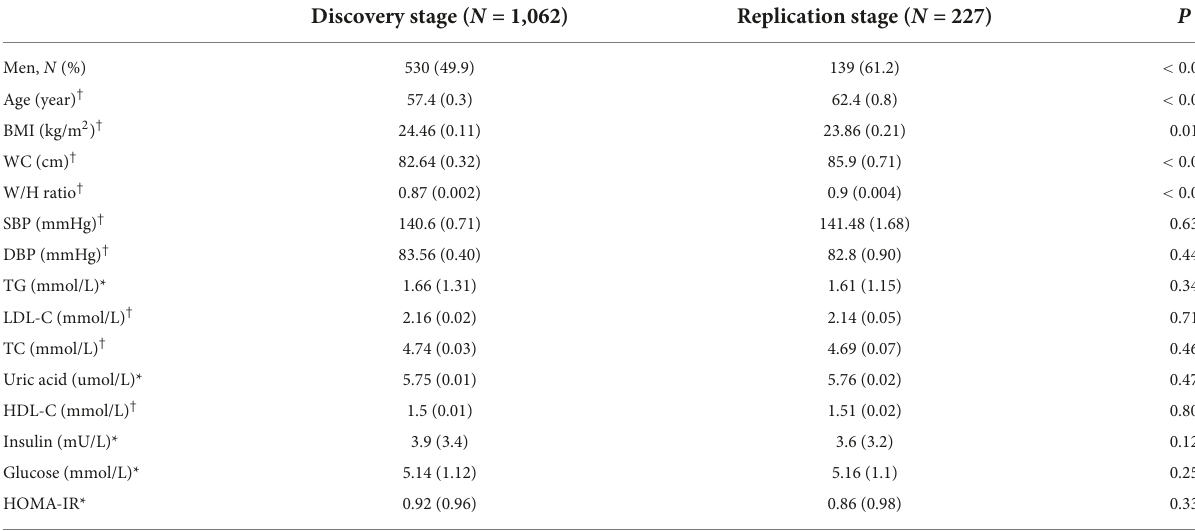
TABLE 1 Characteristics of subjects in genome-wide association study (GWAS)